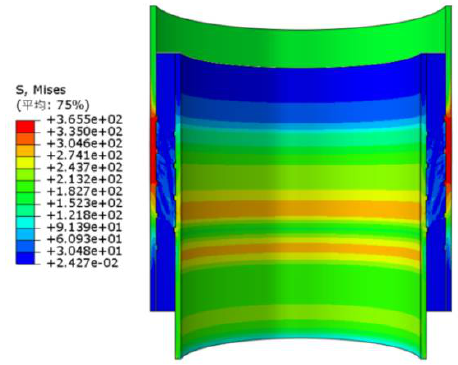
Figure 5. Mises stress of the grouted Figure 5 . Mises stress of the grouted joint.